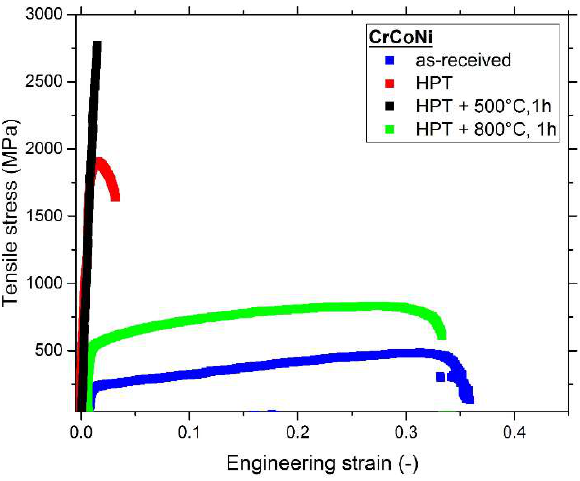
Figure 9. Tensile curves of the as-received state, the nanocrystalline HPT state and two annealed states of the CrCoNi alloy.